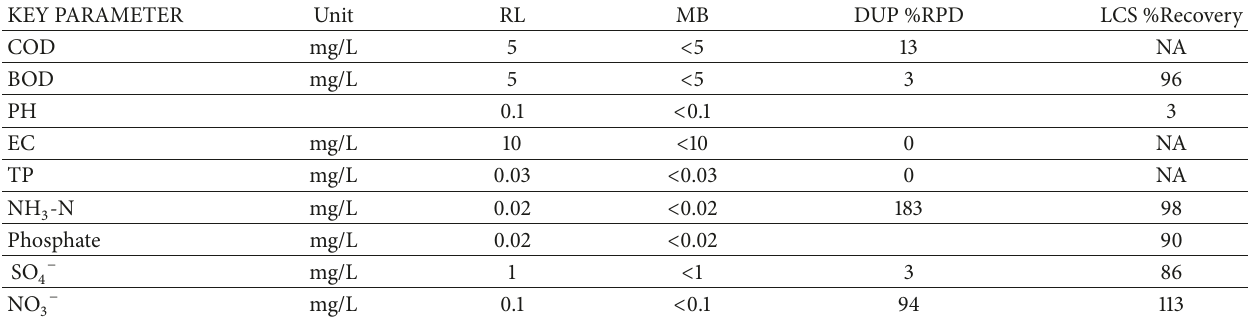
Table 6: Quality control summary on some selected